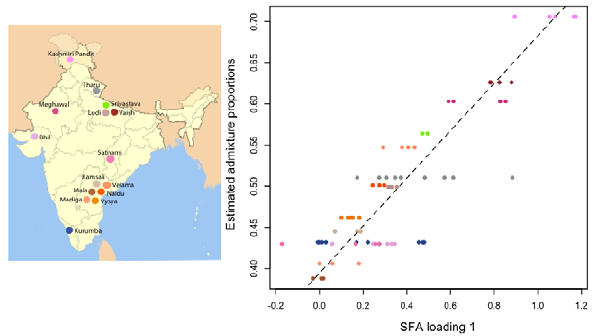
Figure 10. Plot of estimated admixture proportions of each Indian group versus the relative admixture proportions from SFA on the Indian data set. This plot shows good correlation between the relative admixture proportions from SFA and the estimated admixture proportions from previous work. The colors coding the groups are described in the India